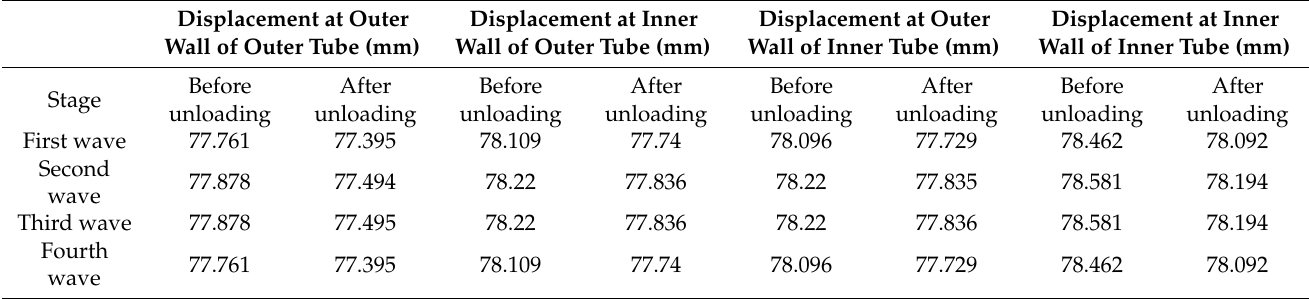
Table 2. Displacements at wave height before and after